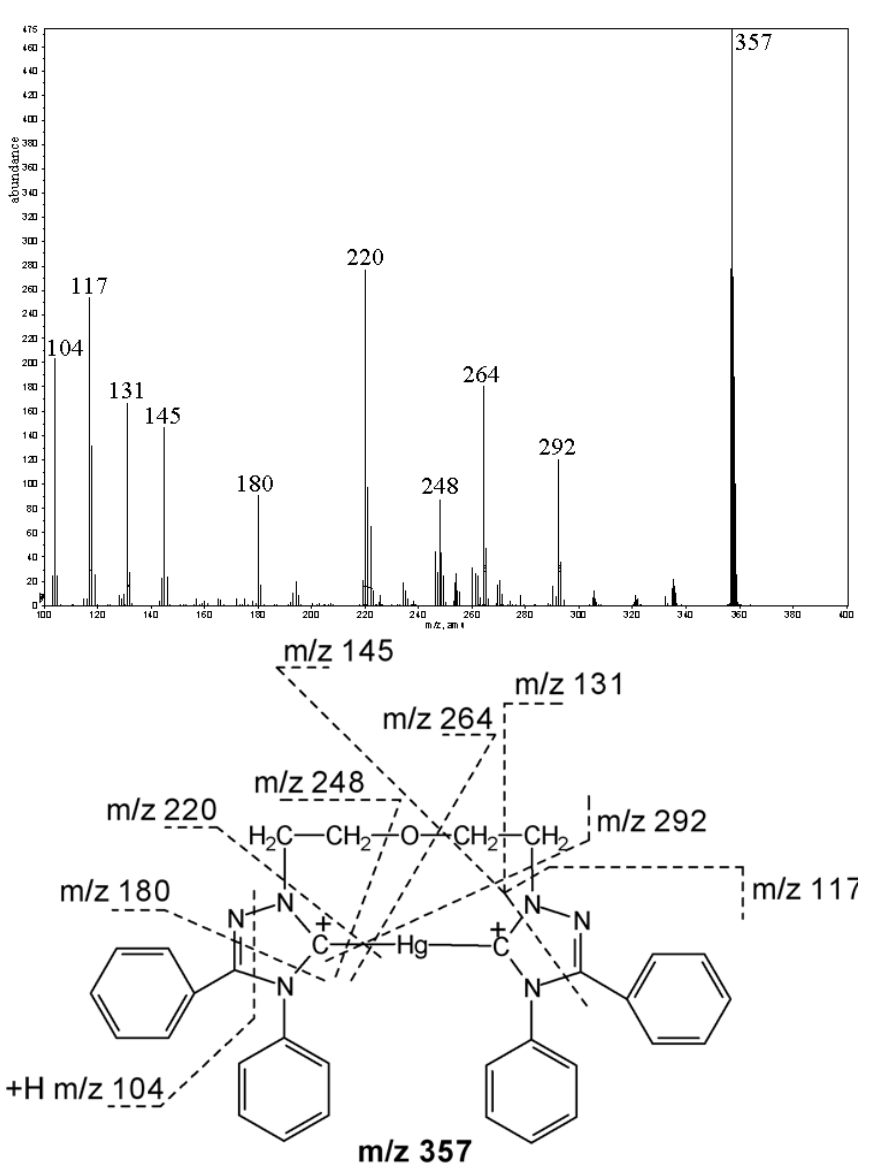
Fig. 4 MS/MS spectrum of [ 6 +Hg] +2 at m/z 357 (collision energy 30 eV) and fragmen- tation pathway